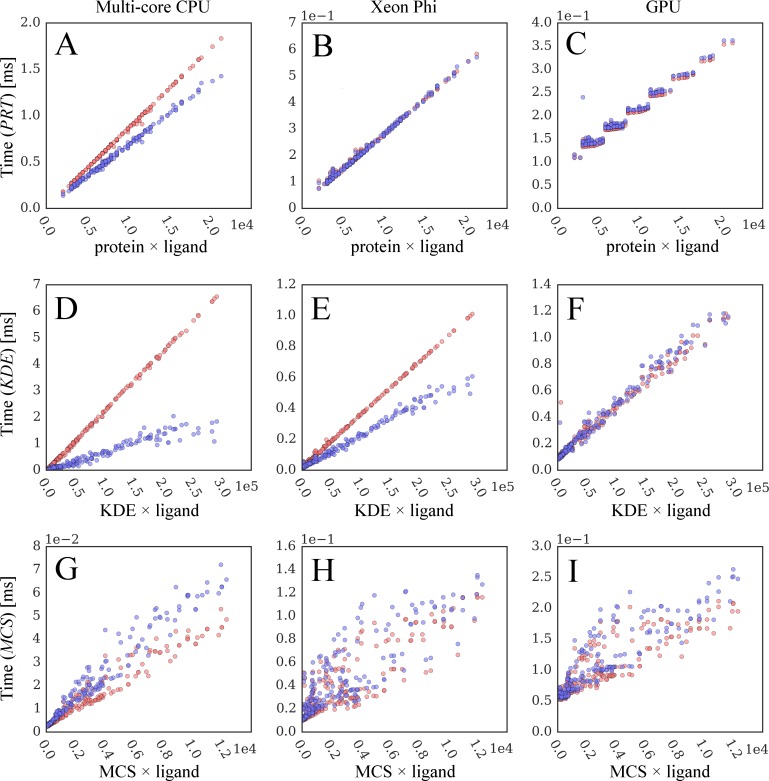
Correlation between computing time and static data size.Blue points are collected from original GeauxDock, whereas red points correspond to a modified docking code, where dynamic branches are turned off forcing the execution of all instructions. Three major operations compute (A-C) proteinColumnVector × ligandRowVector (PRT), (D-F) KDEColumnVector × ligandRowVector (KDE), and (G-I) MCSMatrix × ligandColumnVector (MCS) matrices. Three kernel implementations are tested for (A, D, G) multi-core CPU, (B, E, H) Xeon Phi, and (C, F, I) GPU.